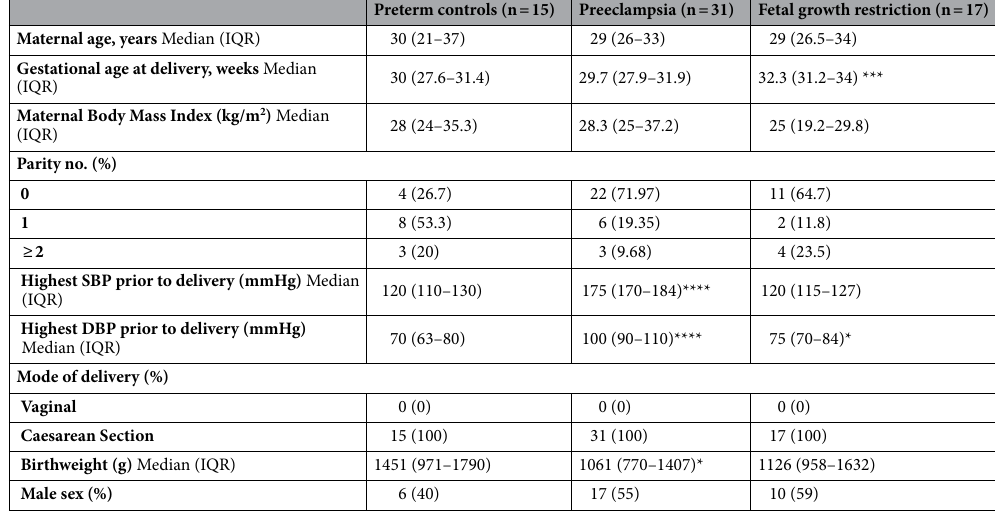
Table 4. Patient characteristics of women with preeclampsia, fetal growth restriction and preterm control samples for protein studies. BMI data unavailable for n = 4 preterm control, n = 7 preeclamptic, n = 1 fetal growth restricted samples. * p < 0.05, *** p < 0.001, **** p < 0.0001. Statistical analysis was by t test comparing the preeclamptic or fetal growth restricted samples to the preterm